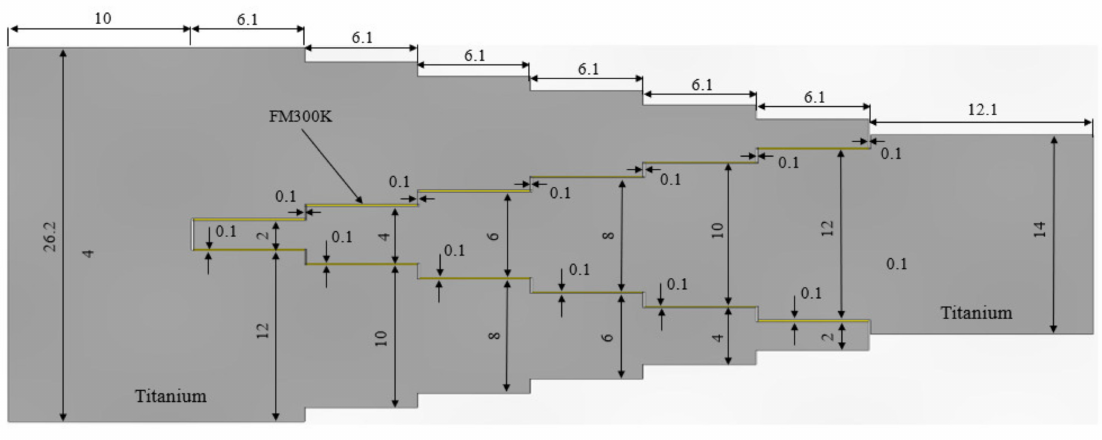
Figure A6. Schematic diagram of the cross-section of the six-step bonded joint, dimensions are in mm.